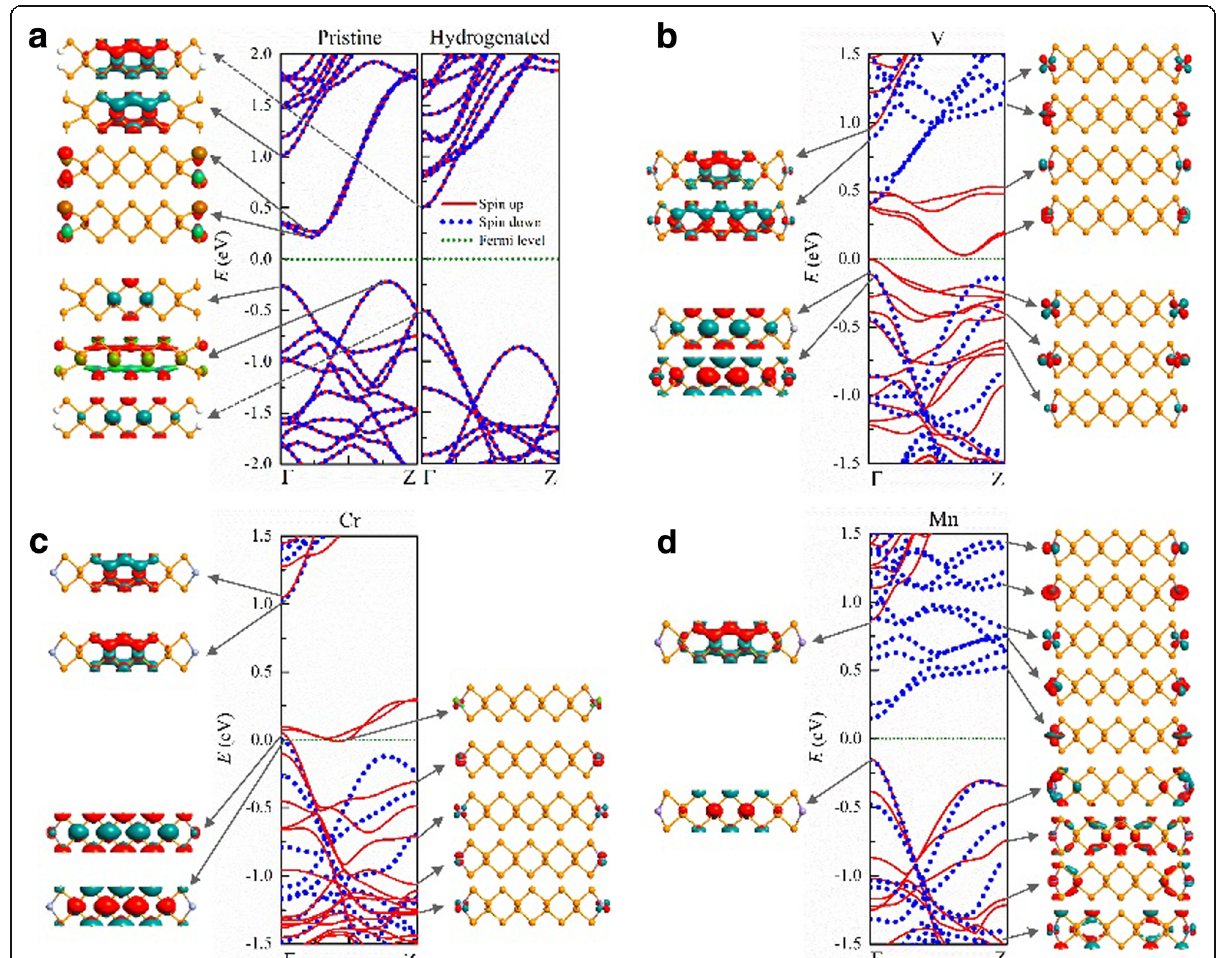
Fig. 3 Band structures and typical wave functions near the Fermi energy of pristine 9-APNRs edge-modified by a H, b V, c Cr, and d Mn